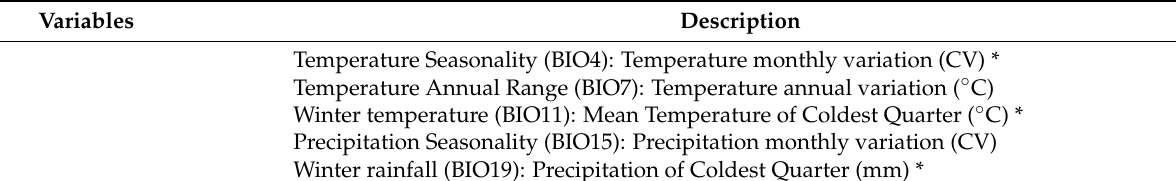
Table 1. Environmental data collected for Aquila chrysaetos and Aquila fasciata nesting territories on Crete and used as explanatory variables for species distribution modeling and ecological niche